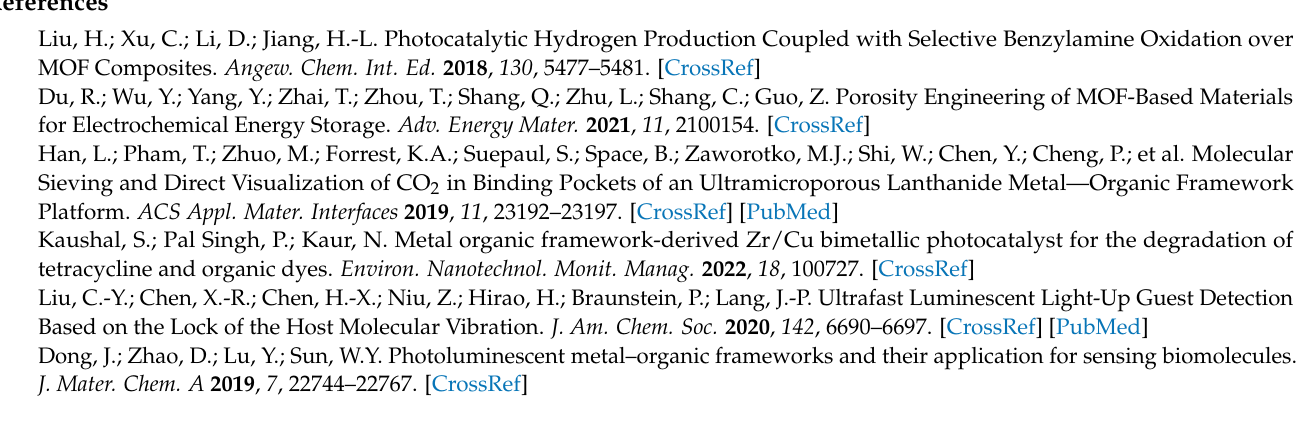
Figure S6: Solid-state UV-vis absorption spectrum of ( a ) Tb-TATB and ( b ) Eu-TATB in different pH; Figure S7: ( a ) Specific surface area and ( b ) micropore size distribution of Tb-TATB. ( c ) Specific surface area ( d ) and micropore size distribution of Eu-TATB; Table S1: Crystal data and structure refinement for Eu-TATB; Table S2: Bond lengths [Å] for Eu-TATB; Table S3: Bond and angles [ ◦ ] for Eu-TATB; Table S4: Crystal data and structure refinement for Tb-TATB; Table S5: Bond lengths [Å] for Tb-TATB; and Table S6. Bond angles [ ◦ ] for